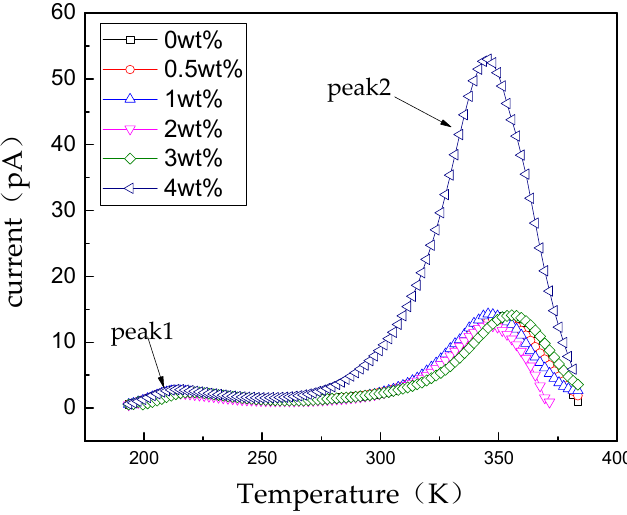
Figure 12. TSC curves of RIP with different nano-SiO 2 doping components.